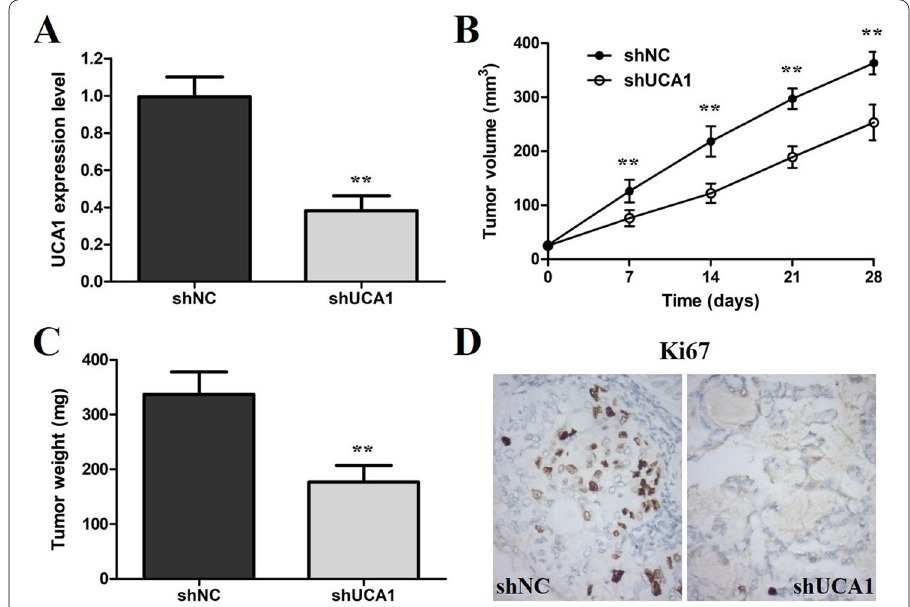
Fig. 5 UCA1 knockdown inhibited tumor growth of GC in vivo. A Q-PCR verified the knockdown effect of shUCA1. B The tumor volume curve of nude mice was drawn and UCA1 knockdown inhibited MGC-803 tumor growth in vivo. C Tumor weights of nude mice were recorded. D IHC revealed that xenograft tumors derived from MGC-803 cells with UCA1 knockdown had lower expression of Ki67. **p < 0.01, compared with the control